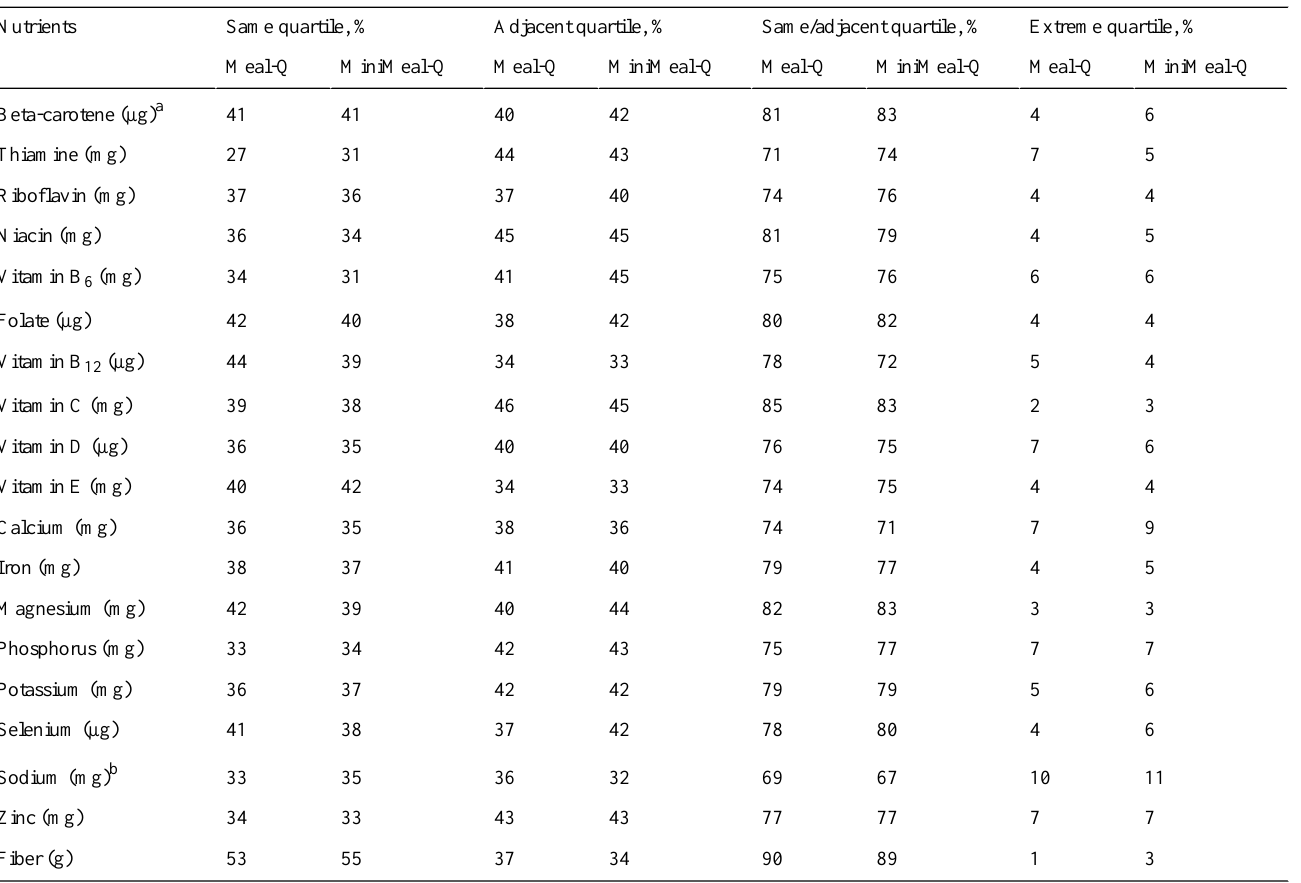
Table 3. Quartile cross-classifications of mean daily energy-adjusted micronutrient and fiber intake assessed with Meal-Q, MiniMeal-Q, and the weighed food record (WFR)